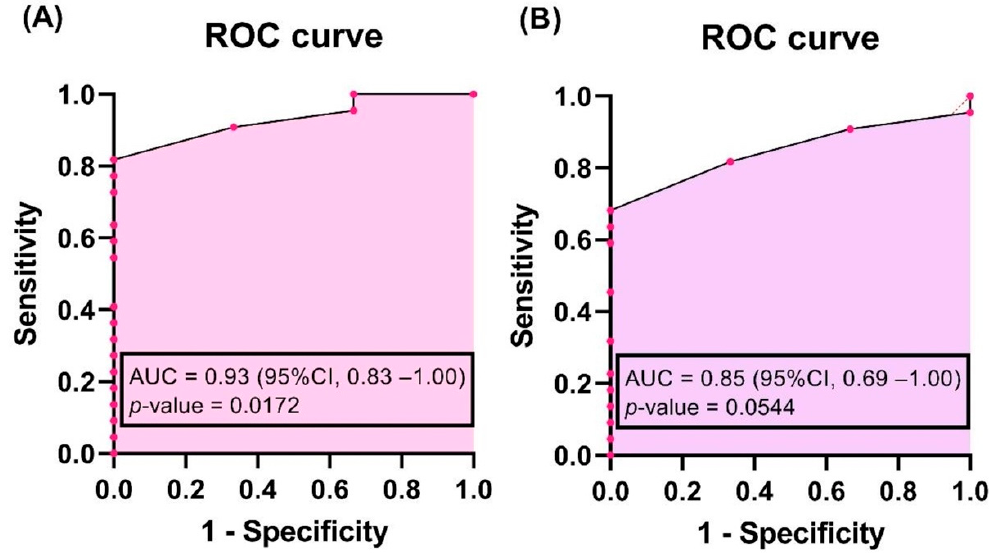
Figure 1. Receiver operating characteristic curve for modelling toothbrushing presence. ( A )